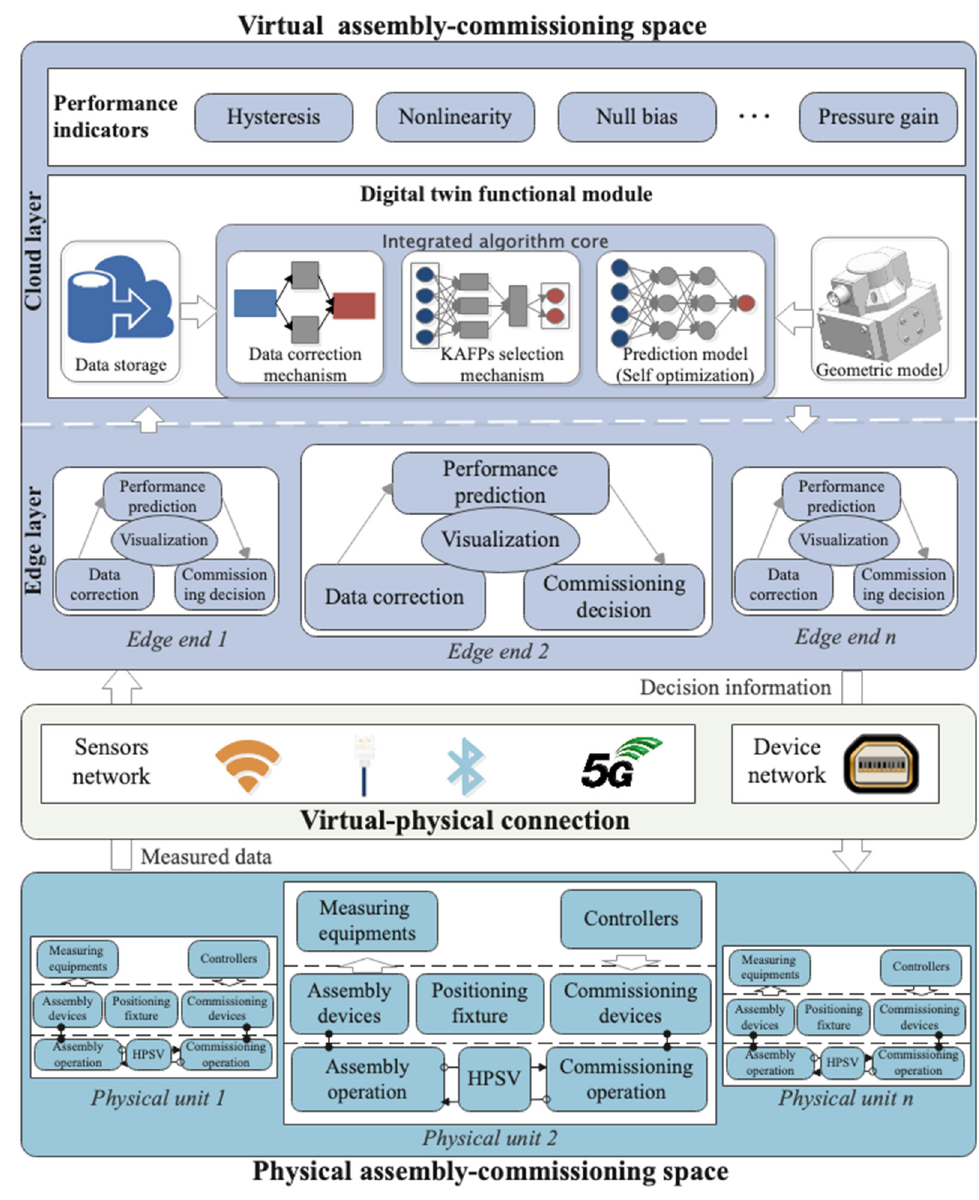
Figure 2. The framework for performance prediction supported by digital